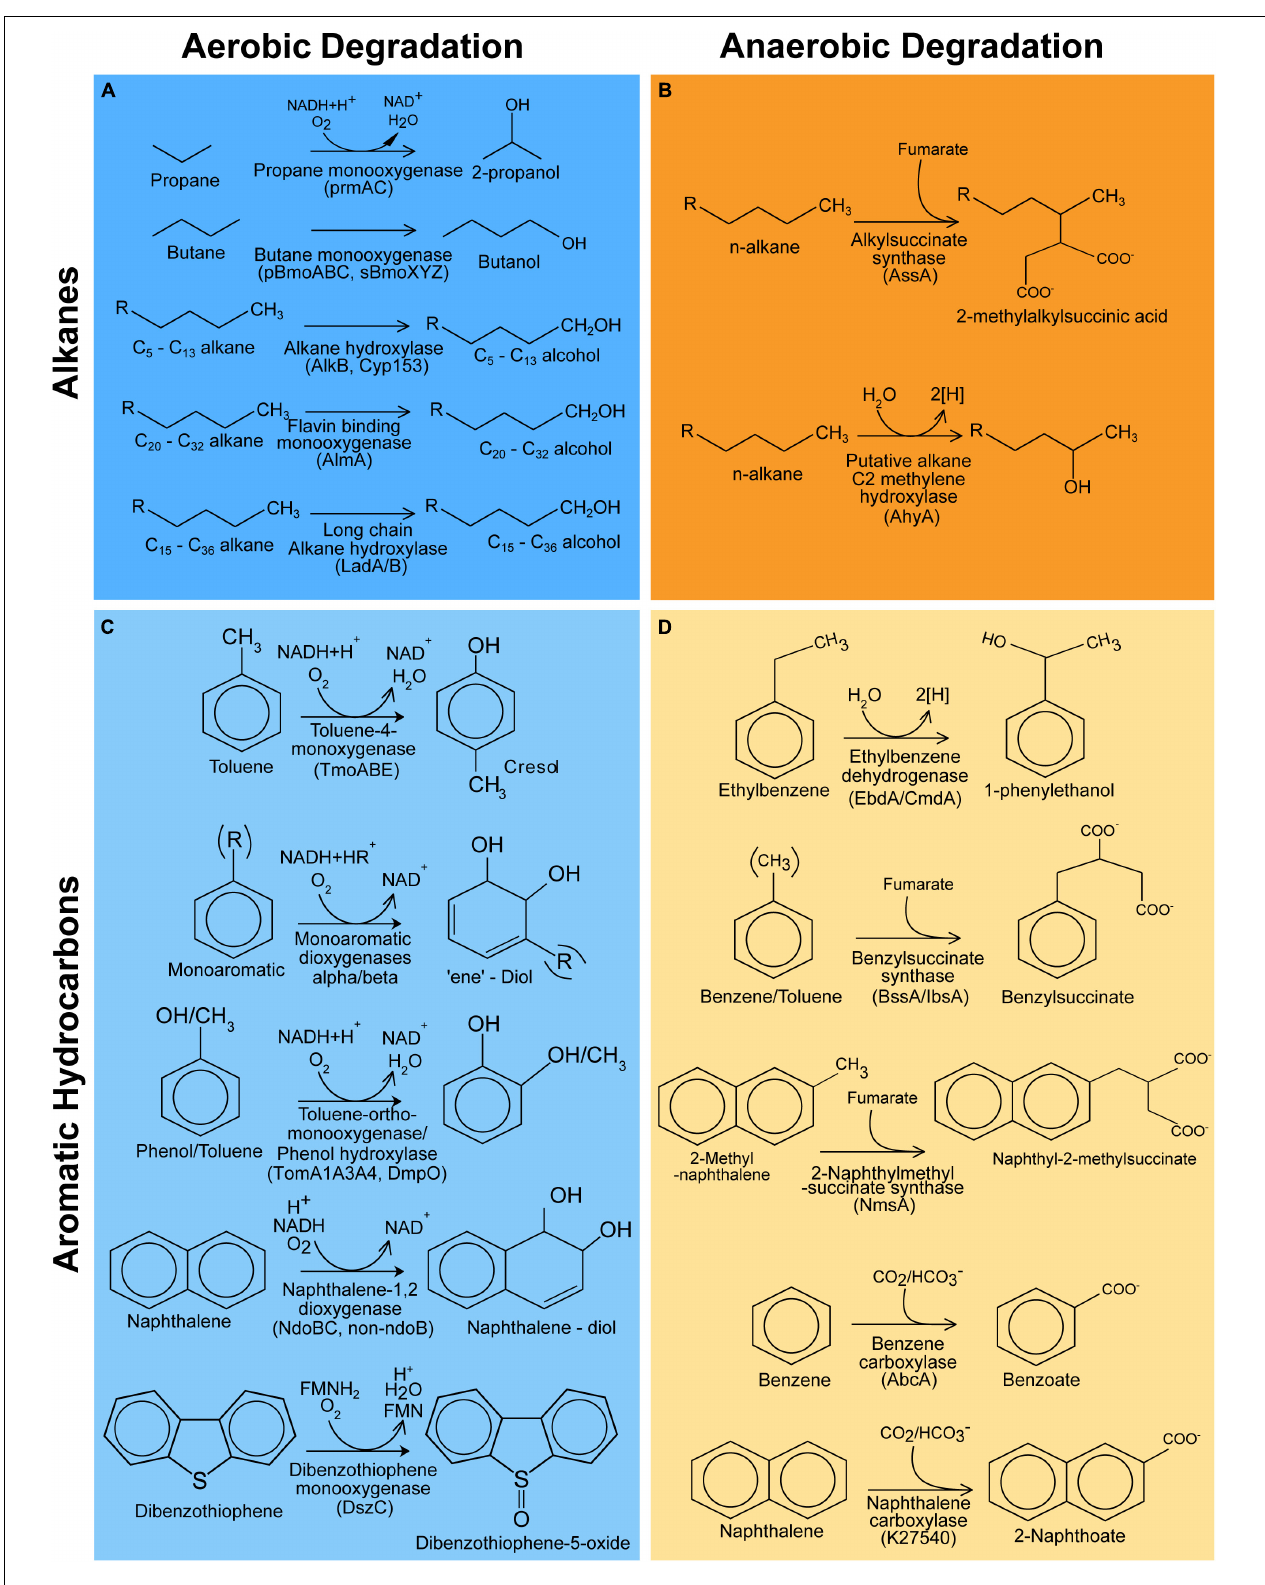
FIGURE 1 | Hydrocarbon degradation reactions covered by CANT-HYD. Reactions for the degradation of alkanes through aerobic (A) and anaerobic pathways (B) and degradation of aromatic hydrocarbons through aerobic (C) and anaerobic (D) pathways.